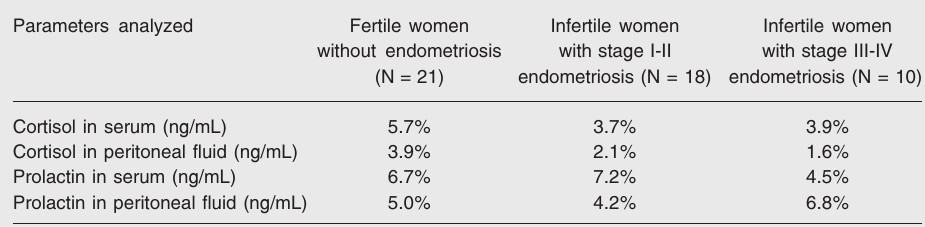
Table 1. Margin of error based on the number of patients included in each group for the collection of blood and peritoneal fluid. Parameters